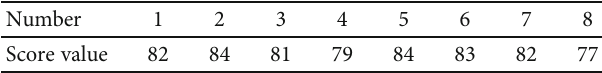
Table 2: Coal seam condition (C11)